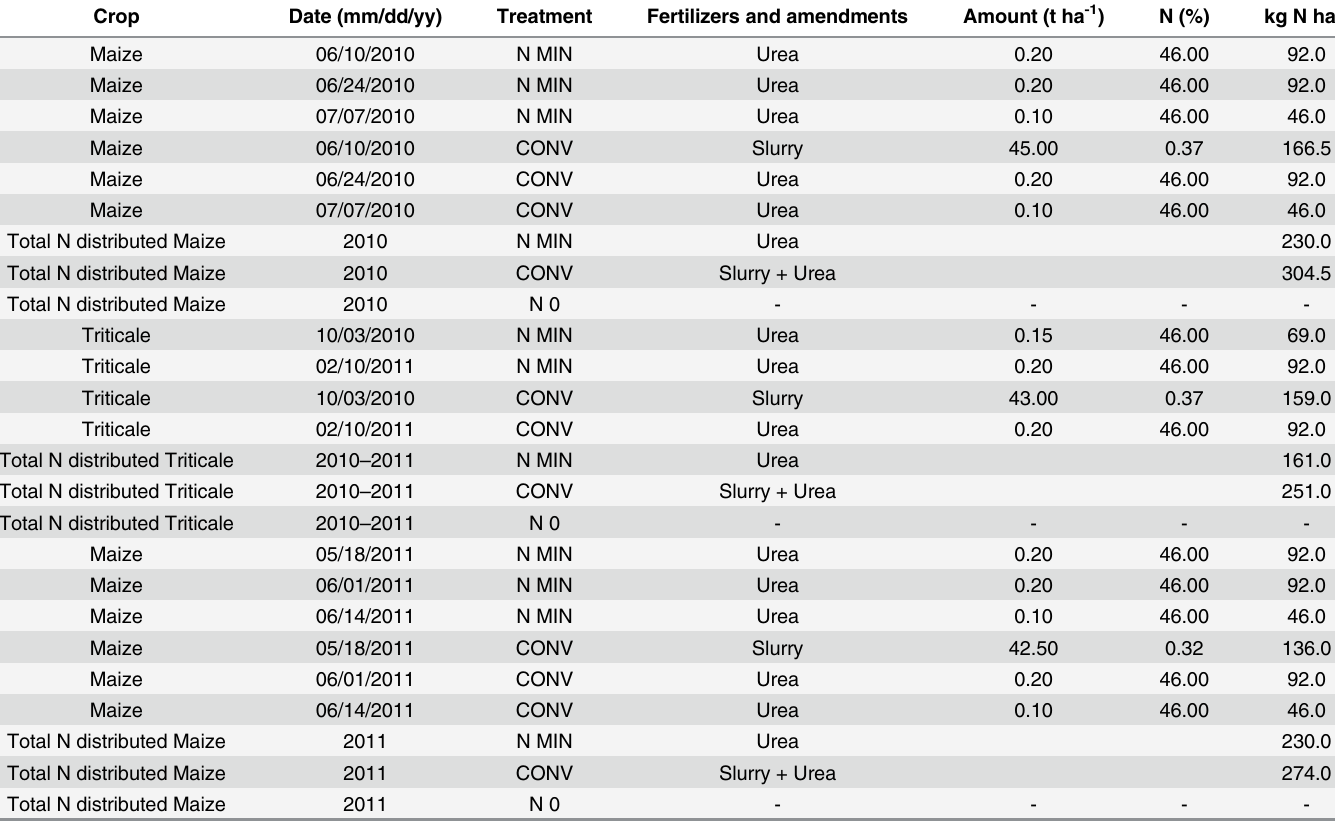
Table 1. Fertilizers and organic amendments rates, N content and dates of application.